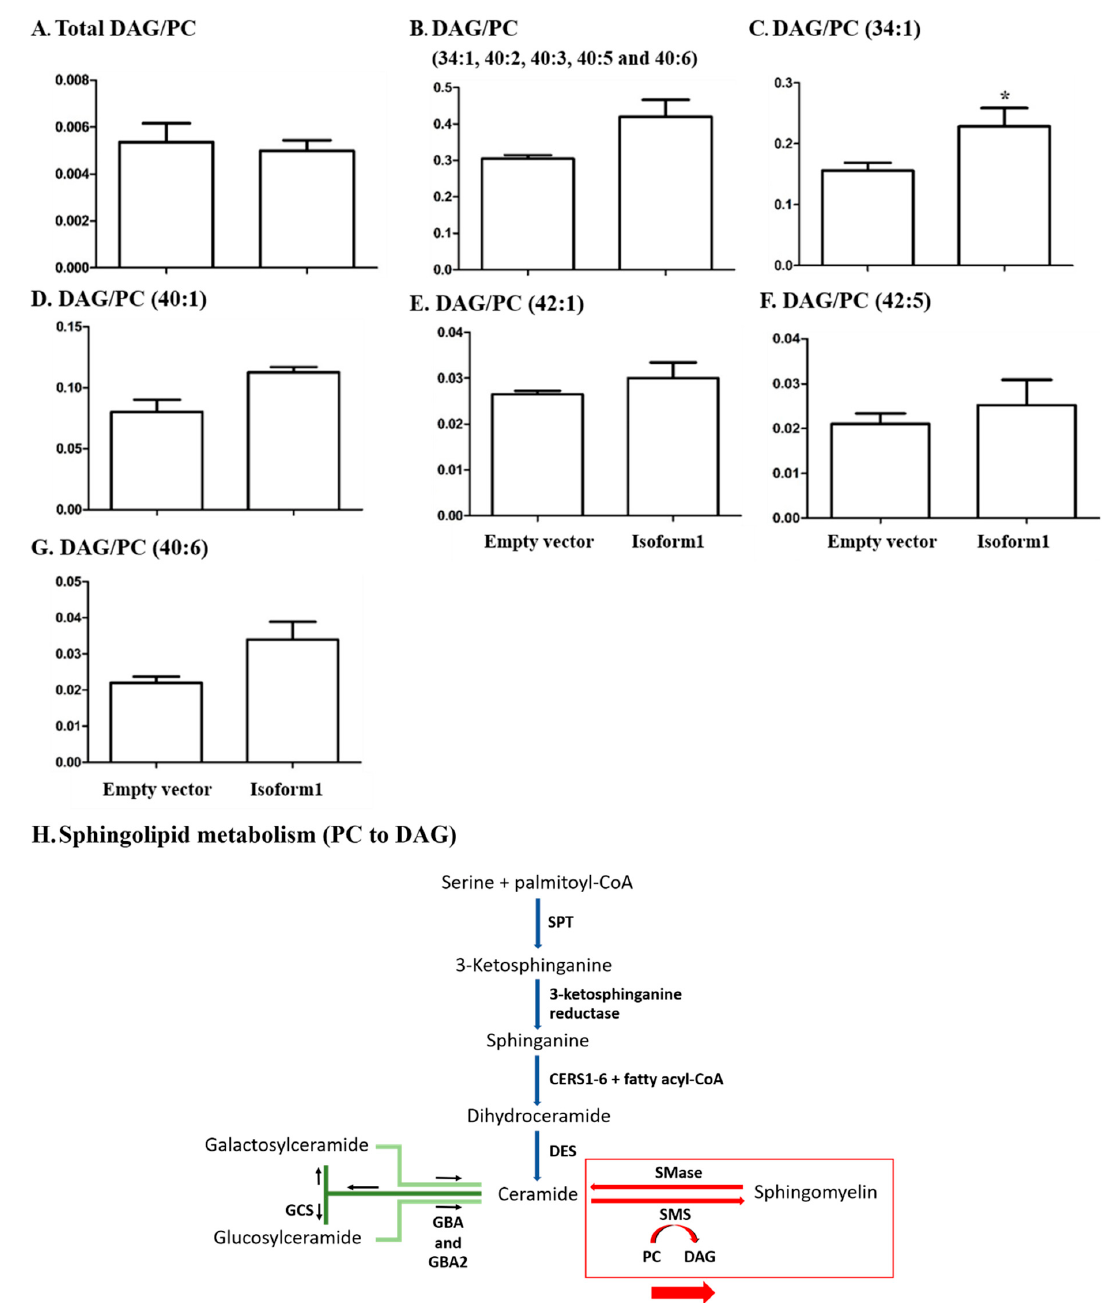
Figure 7. Ratios of levels of diacylglycerol to phosphatidylcholine in COS-7 cells transfected with control vector and GBA2 isoform 1 expression vector for 48 h. The ratios of total diacylglycerol (DAG) to total phosphatidylcholine (PC) are shown in ( A ). Total DAG / PC for those lipid species found in both lipid classes 34:1, 40:2, 40:3, 40:5, and d40:6) are shown in ( B ). The individual DAG / PC ratios for 34:1, 40:1, 42:1, and 42:2 are shown in ( C – G ), respectively. Data are expressed as mean of three independent biological replicates ± SD, * indicates p < 0.05 in the unpaired t-test. The distributions of sample values for all conditions did not deviate significantly from a normal distribution in a Shapiro–Wilk test. ( H ) Sphingolipid metabolism showing conversion of ceramide to sphingomyelin, which is affected by GBA2 overexpression, with emphasis on the conversion of PC to DAG during SM synthesis .